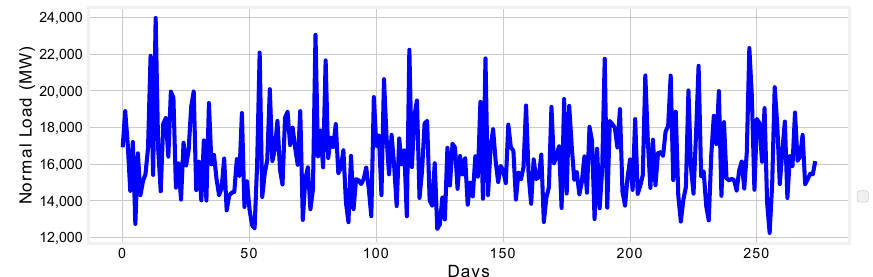
Figure 10. Normal electricity load according to the dataset.